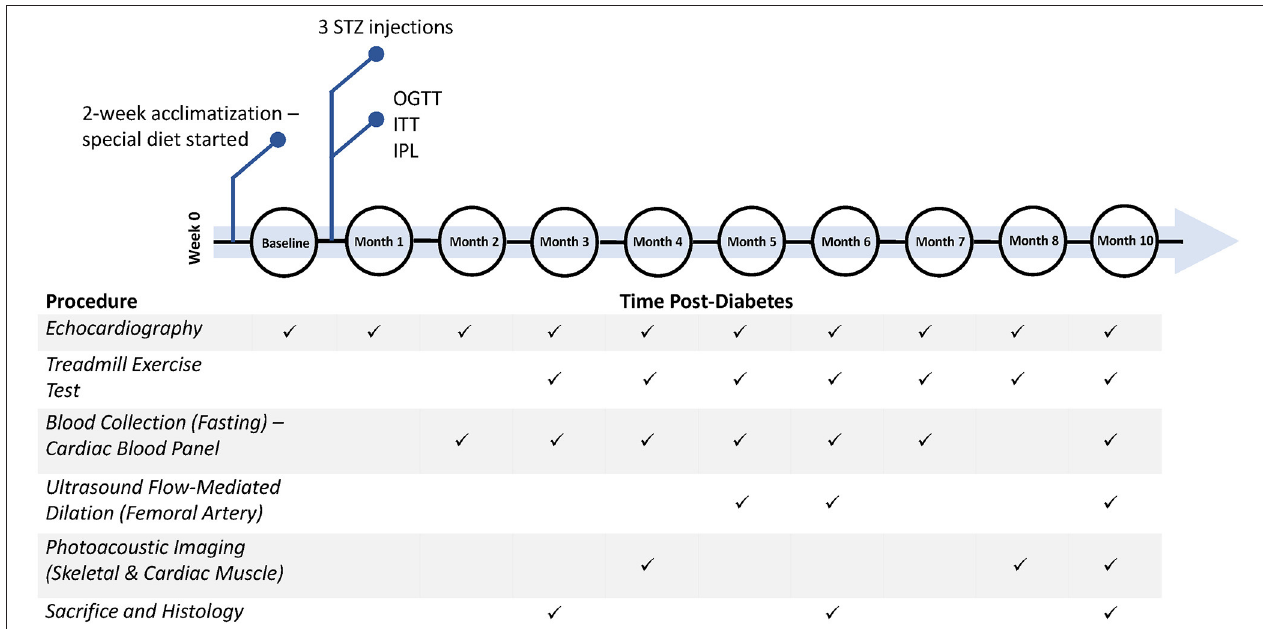
FIGURE 1 | Timeline of diabetes induction and post-diabetes monitoring and assessment. Additional measurements not shown include weekly weight, weekly non-fasting blood glucose, and monthly blood pressure measurements. STZ, streptozotocin; OGTT, oral glucose tolerance test; ITT, insulin tolerance test; IPL, insulin plasma